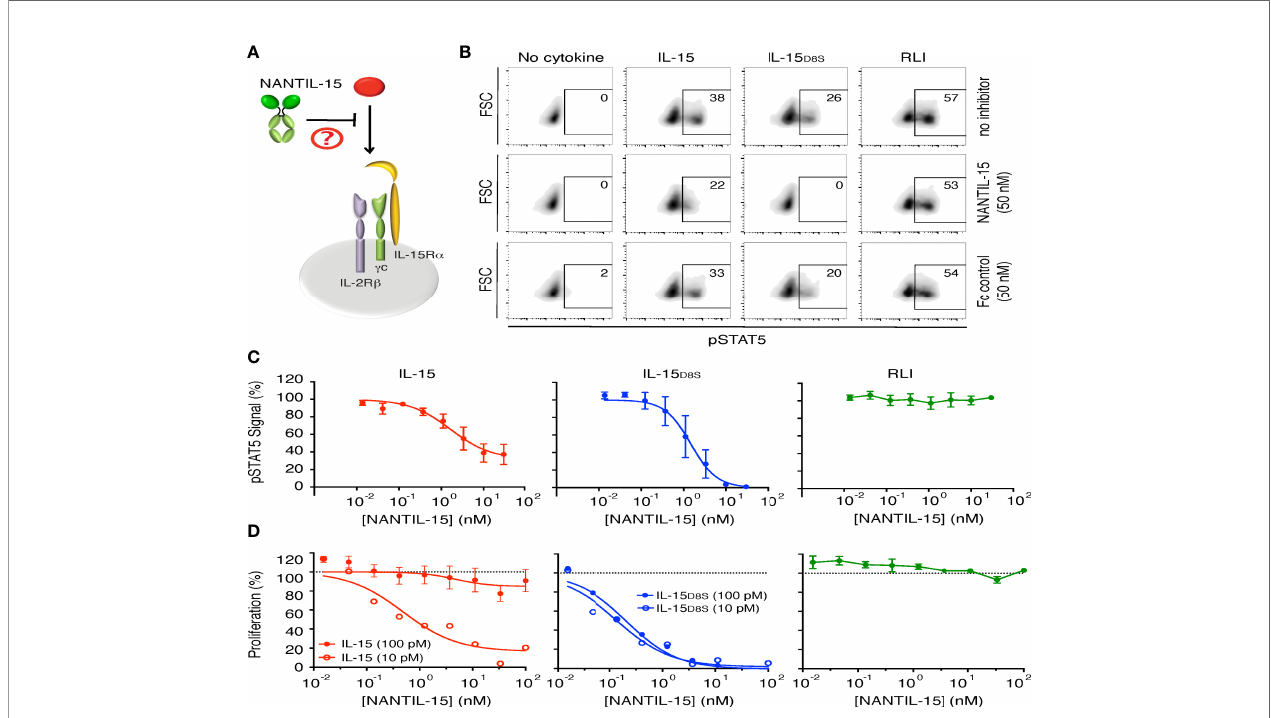
FIGURE 3 | NANTIL-15 selectively inhibits IL-15 ’ s signaling through trimeric IL-15R a /IL-2R b / g c receptor. (A) Diagram showing NANTIL-15 acting on the signaling of IL-15 through the trimeric IL-15R a /IL-2R b / g c receptor. (B) Inhibition of IL-15 (50 pM)-, IL-15D8S (300 pM)-, and RLI (100 pM)-induced Stat5 phosphorylation by 50 nM of NANTIL-15 or Fc control within Kit225 cells. Number indicated the percentage of pStat5-positive cells. (C) Analysis of relative pStat5 levels in Kit225 cells in response to fi xed concentrations of IL-15 (100 pM), IL-15 D8S (300 pM), or RLI (3 nM) in the presence of increasing concentrations of NANTIL-15, by AlphaScreen technology. (D) Inhibition of IL-15 (10 or 100 pM), IL-15 D8S (10 or 100 pM), or RLI (100 pM) induced Kit225 cell proliferation by increasing concentrations of NANTIL- 15. Data are representative of at least three separate